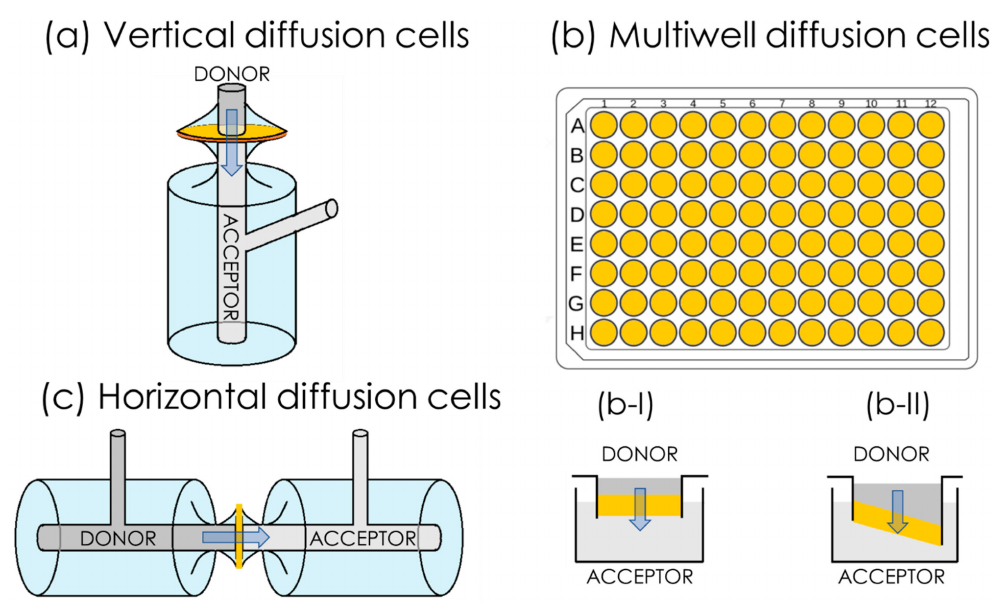
Figure 5. Schematic representation of set-ups for permeability assays. Permeability assays are based on two compartments, the donor and the acceptor, separated by a (biomimetic) barrier, i.e., the yellow segments in the figure. In general, permeability tests can be performed utilizing macroscopic diffusion cells, in which the diffusion of the drug takes place vertically, i.e., from top to bottom (or the reverse) ( a ), or horizontally, i.e., from side to side ( c ). In order to increase the potential of this method for high-throughput screening (HTS), several permeability assays are available in the multiwell-plate format ( b ), in which a (biomimetic) barrier is attached to the top plate horizontally ( b-I ) or at an angle ( b-II ) in order to reduce the risk of air bubble